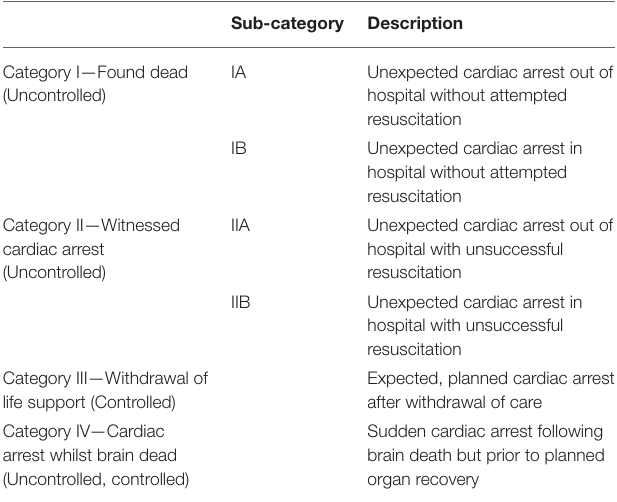
TABLE 1 | Modified Maastricht criteria for donation following cardiac